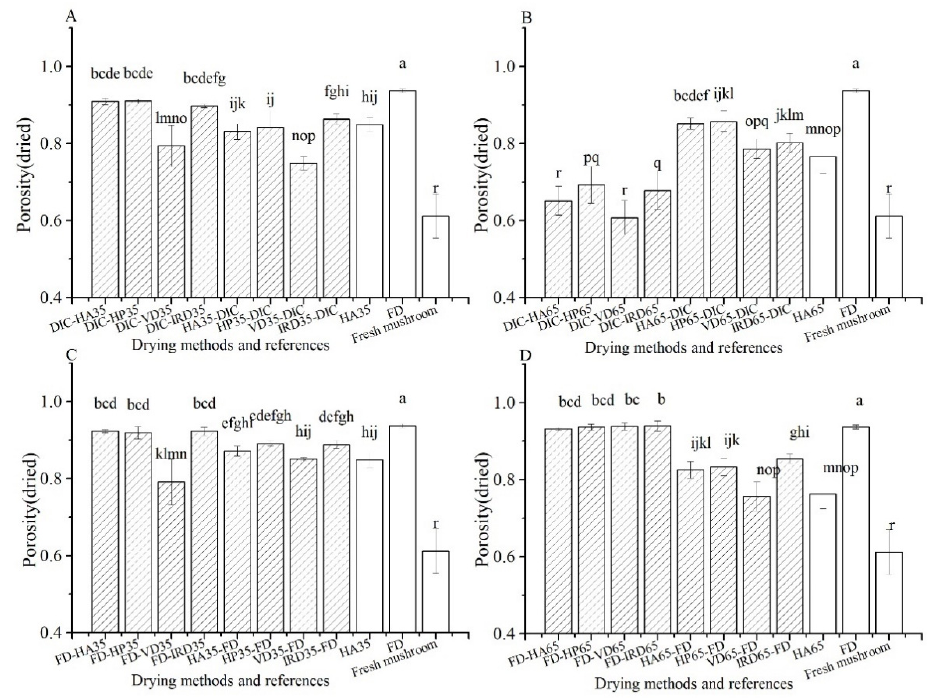
Figure 2. Volume recovery ratio of mushrooms after rehydration with different drying methods ( ) and references ( □ ). ( A–D ): group names as shown in Table1. ) and references ( (cid:3) ).